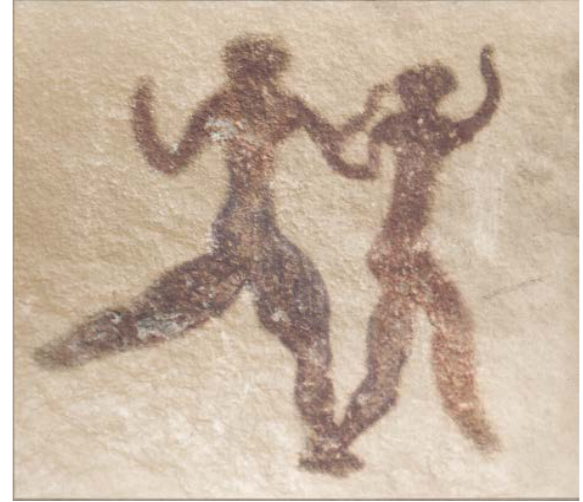
Figure 12. Rekeiz Lemgasem: Painted anthropomorphs from the Dancers’ shelter (from Soler i Subils, 2007).